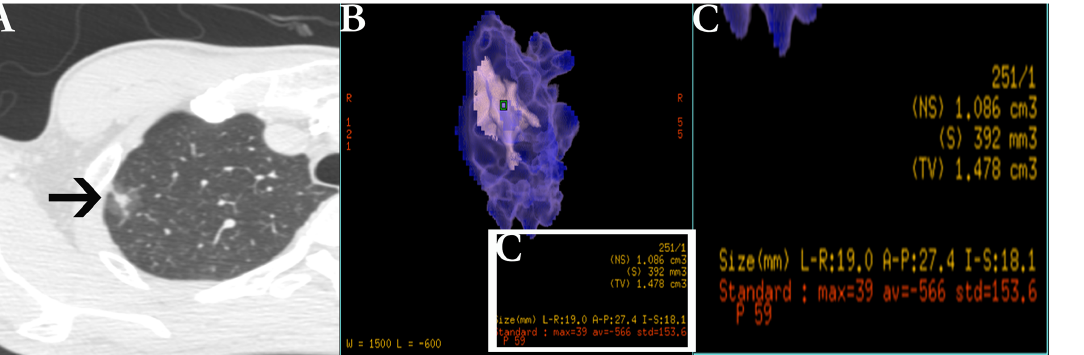
Fig 1. Example of nodule three-dimensional processed and measured on thin-section helical computed tomography (CT) images. (A) Typical ground-glass opacity (GGO, black arrow) nodule on high-resolution CT. (B) The software automatically processed and measured the nodule that be placed a marker (green square) on it. (C) The magnified measurement list of relative image parameters from picture B including diameter, total volume (TV), the maximum CT value (MAX), average CT value (AVG) and standard deviation of CT value (STD).